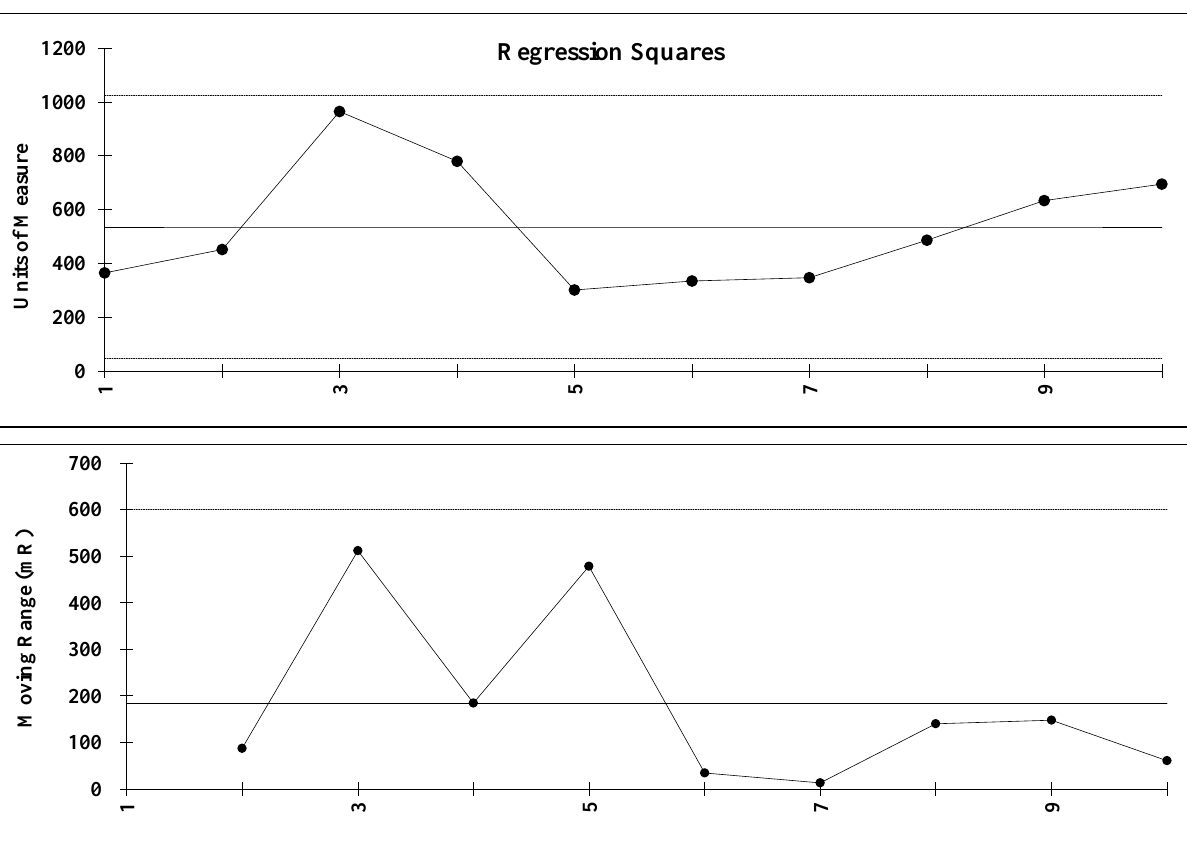
Figure 5. I-MR (XmR) control charts for laboratory self-assessment of the running microbiological assay suitability: row total, column total and preparation